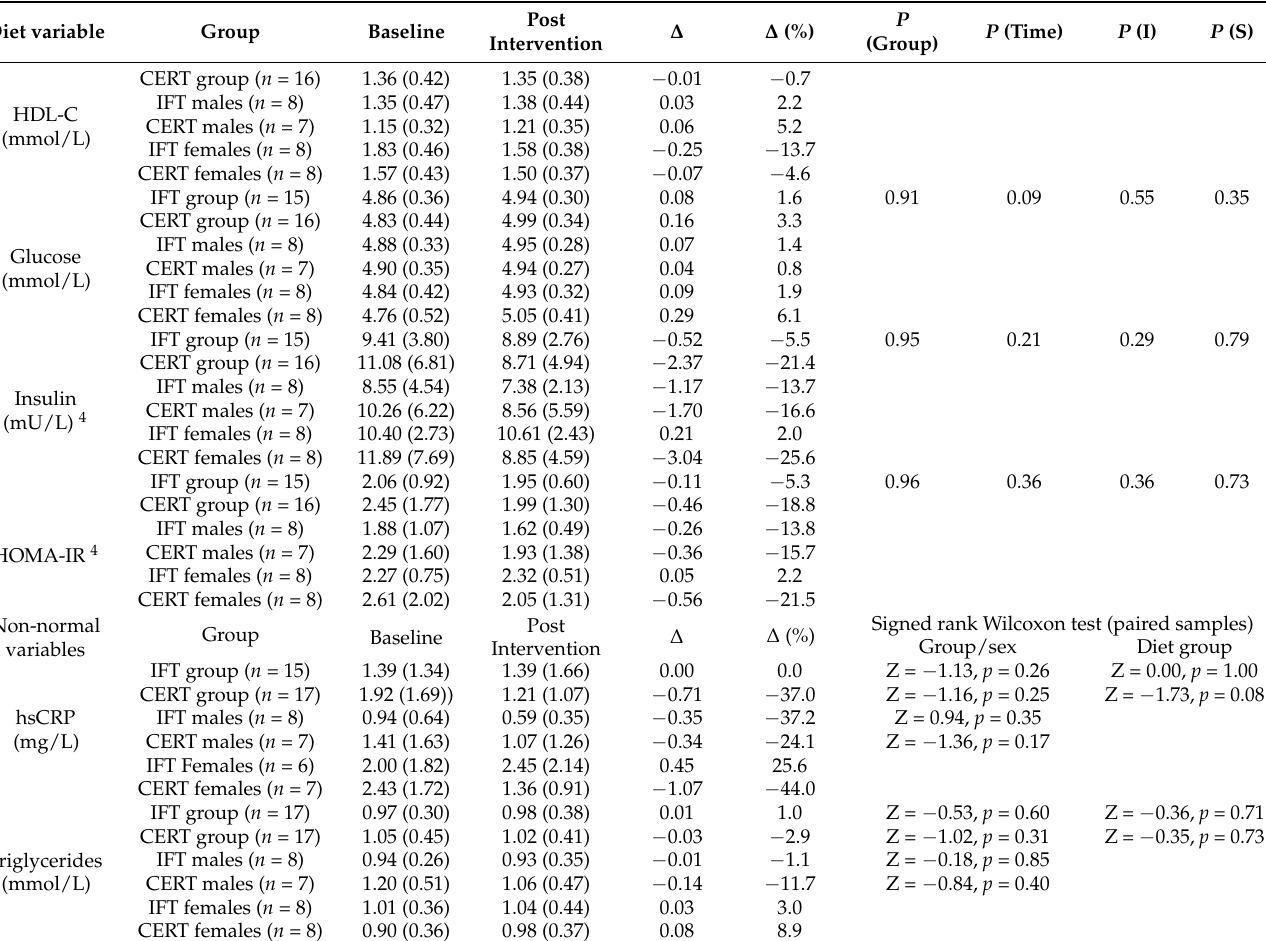
Individual changes for participants where main effects were noted (TC, LDL-C and HDL-C) are shown in Figure